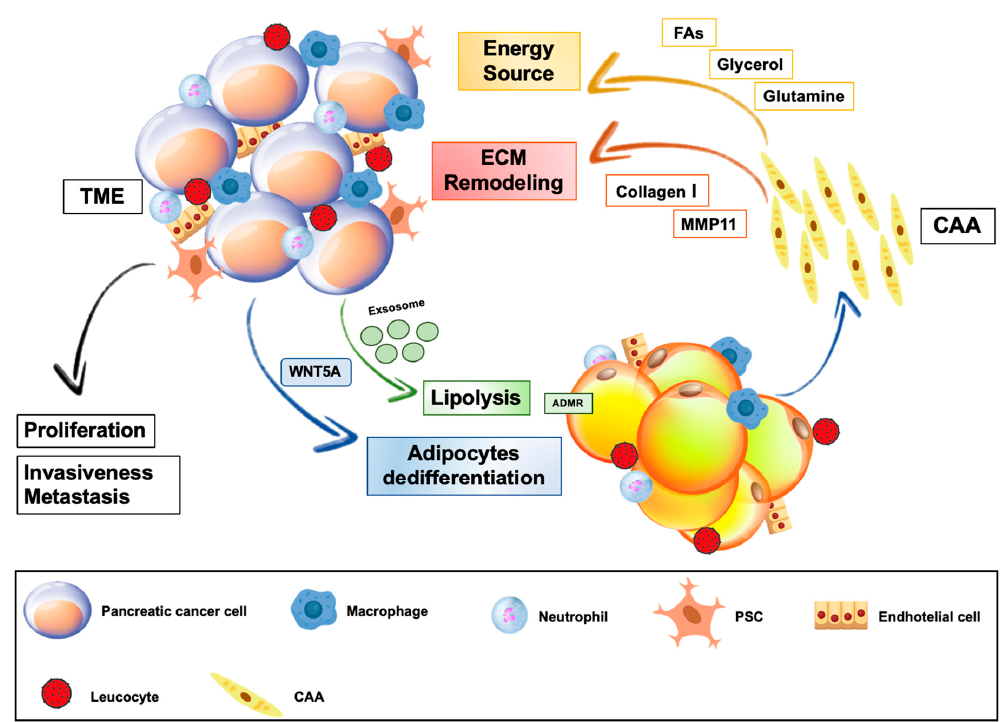
Figure 3. Crosstalk between local adipose tissue and pancreatic cancer. Pancreatic tumor cells stimulate